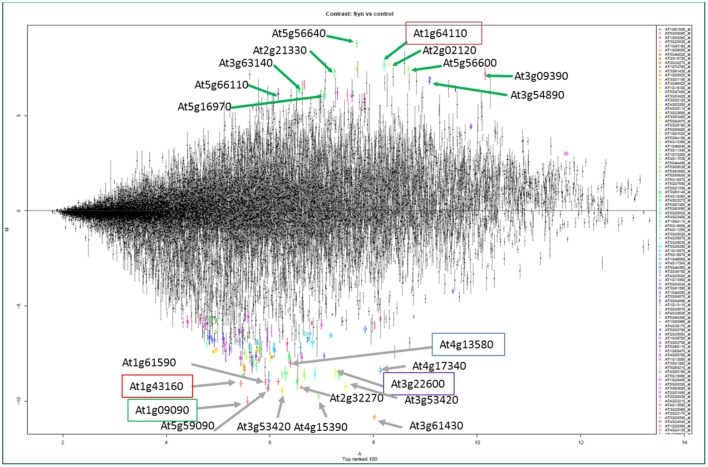
The structure of the transcriptome of syncytia from Szakasits et al. (2009). Strongly up-regulated (above the line) and down-regulated (below the line) genes shown by different colors and letters in the transcriptome of syncytia induced by H. schachtii in Arabidopsis roots. The highlighted genes have been characterized in response to H. schachtii infection in Arabidopsis (Ali, 2012; Ali et al., 2013a,b, 2014).